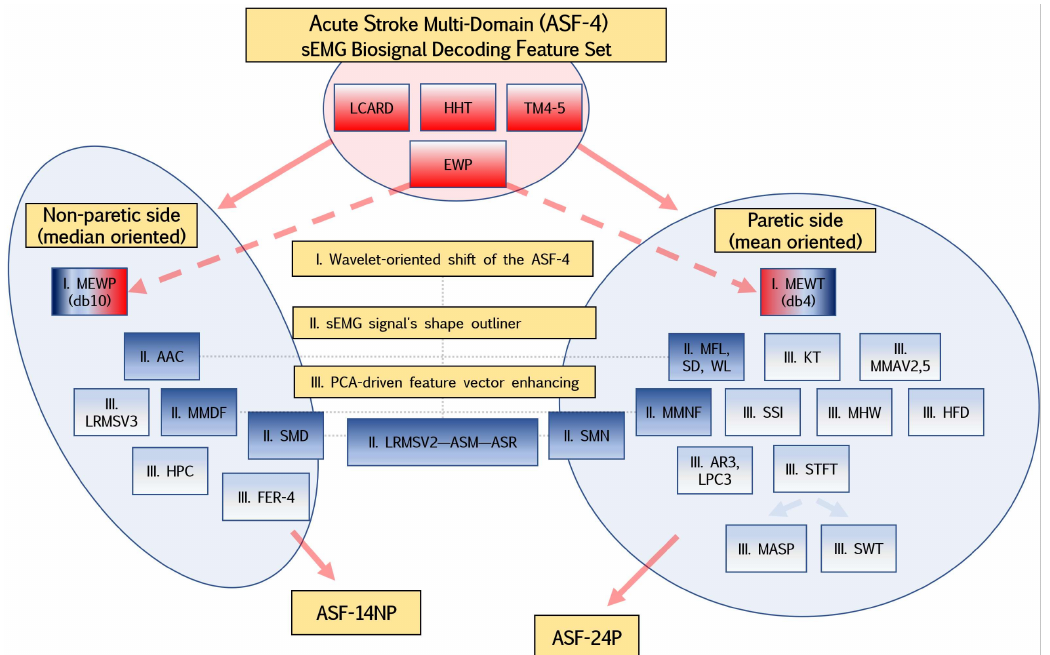
Figure 3. The diagram of the ASF-4 wavelet transformation and additional feature extraction into ASF-14NP and ASF-24P feature sets. The pale-red shape shows the key part of the feature sets, while the blue shapes demonstrate feature concatenation to enhance vector